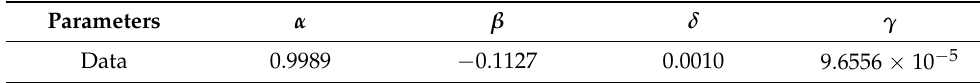
Table 2. Stable distribution